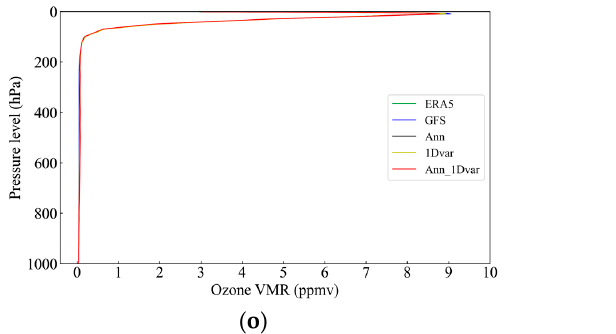
Figure 5. The ozone concentration retrieval profile—( a , b ) 2021_0113_0550, ( c , d ) 2021_0224_0555, ( e , f ) 2021_0526_0530, ( g , h ) 2021_0728_0535, ( i , j ) 2021_0818_0535, ( k , l ) 2021_1110_0540, and ( m , n ) 2021_1114_0605—and ( o , p ) the mean profile of retrieval results of all experimental data from 2021. The column on the left is the ozone concentration profile for 0–1000 hPa, and the column on the right is the ozone concentration profile for 0–200 hPa. The green line, ERA5, is the ERA5 ozone profile. The blue line, GFS, is the ozone profile of GFS forecast data. The black line, Ann, is the initial profile of neural network model and GFS data synthesis. The yellow line, 1Dvar (one-dimensional variational), is the traditional 1D-VAR physical retrieval algorithm retrieval ozone profile result obtained with GFS data as the initial profile, and the red line, Ann_1Dvar, is the retrieval result obtained by adding the neural network method to optimize the initial profile combined with the traditional 1D-VAR physical retrieval algorithm.